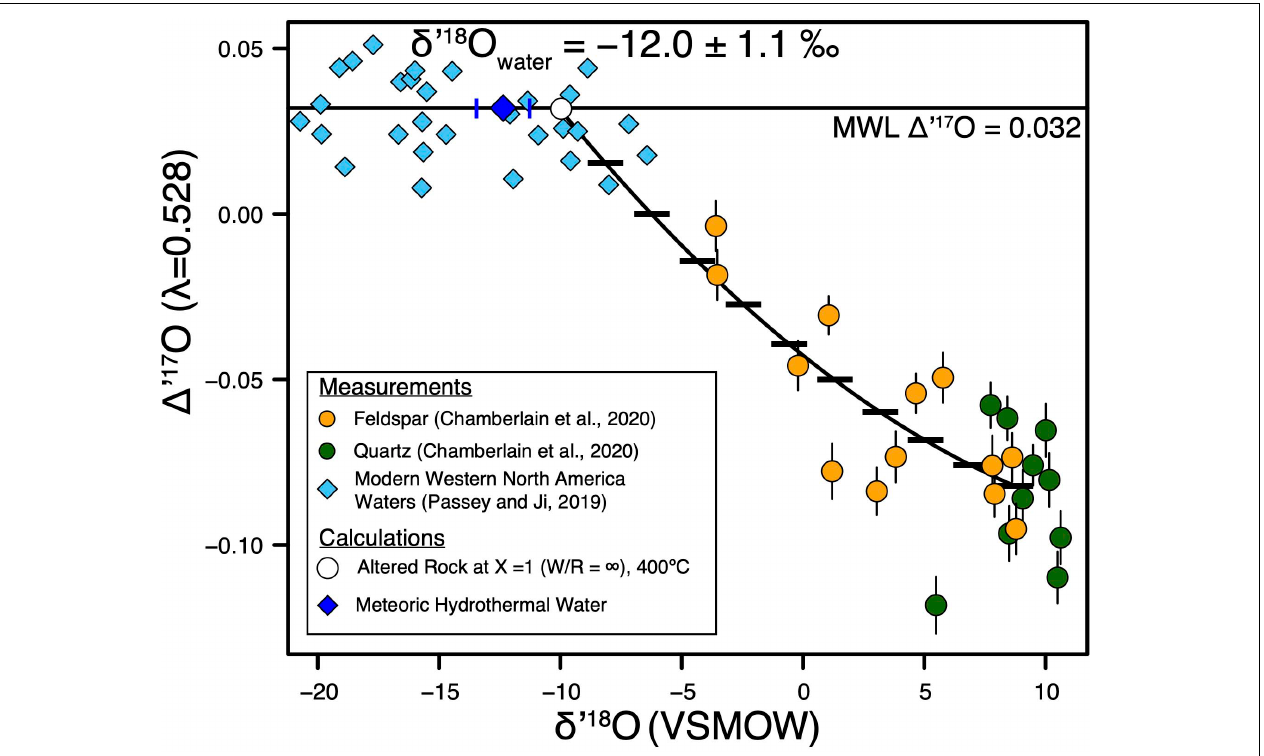
FIGURE 2 | The δ ’ 18 O– (cid:49) ’ 17 O alteration relationship (black line) of feldspar (modified from Chamberlain et al., 2020). The meteoric water line is from Passey and Ji